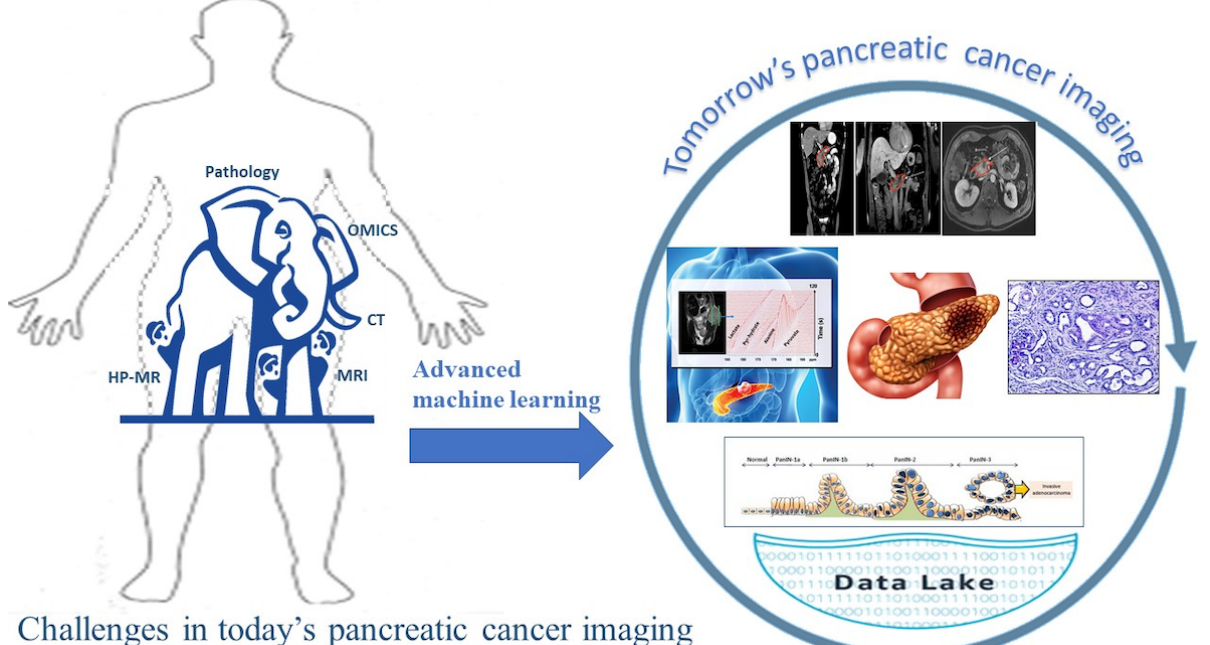
Figure 2. Cartoon showing the challenges of imaging pancreatic cancer at early stages and how artificial intelligence can interface with hyperpolarized magnetic resonance (HP-MR), anatomical magnetic resonance imaging (MRI), and pathology data toward developing biomarkers of pancreatic cancer premalignancy. This approach may become the standard of care in the clinic of the future. CT: computed